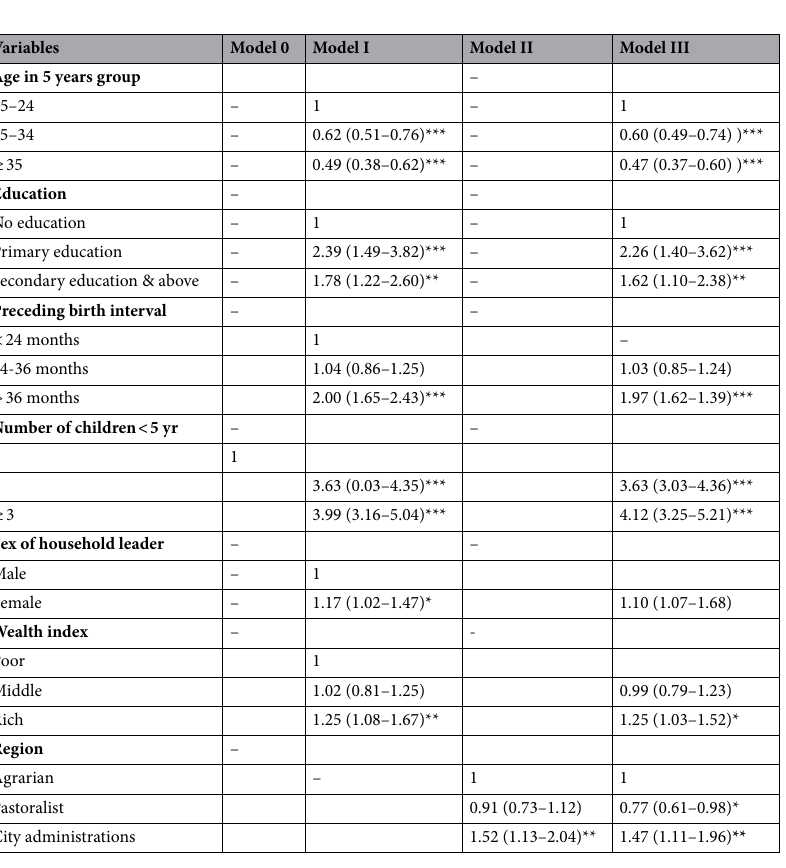
Table 3. Multilevel analysis of timely initiation of complementary feeding among aged 6–23 months in Ethiopia, 2019 EMDHS. NB: * = p < 0.05; ** = p < 0.01; & *** = p <